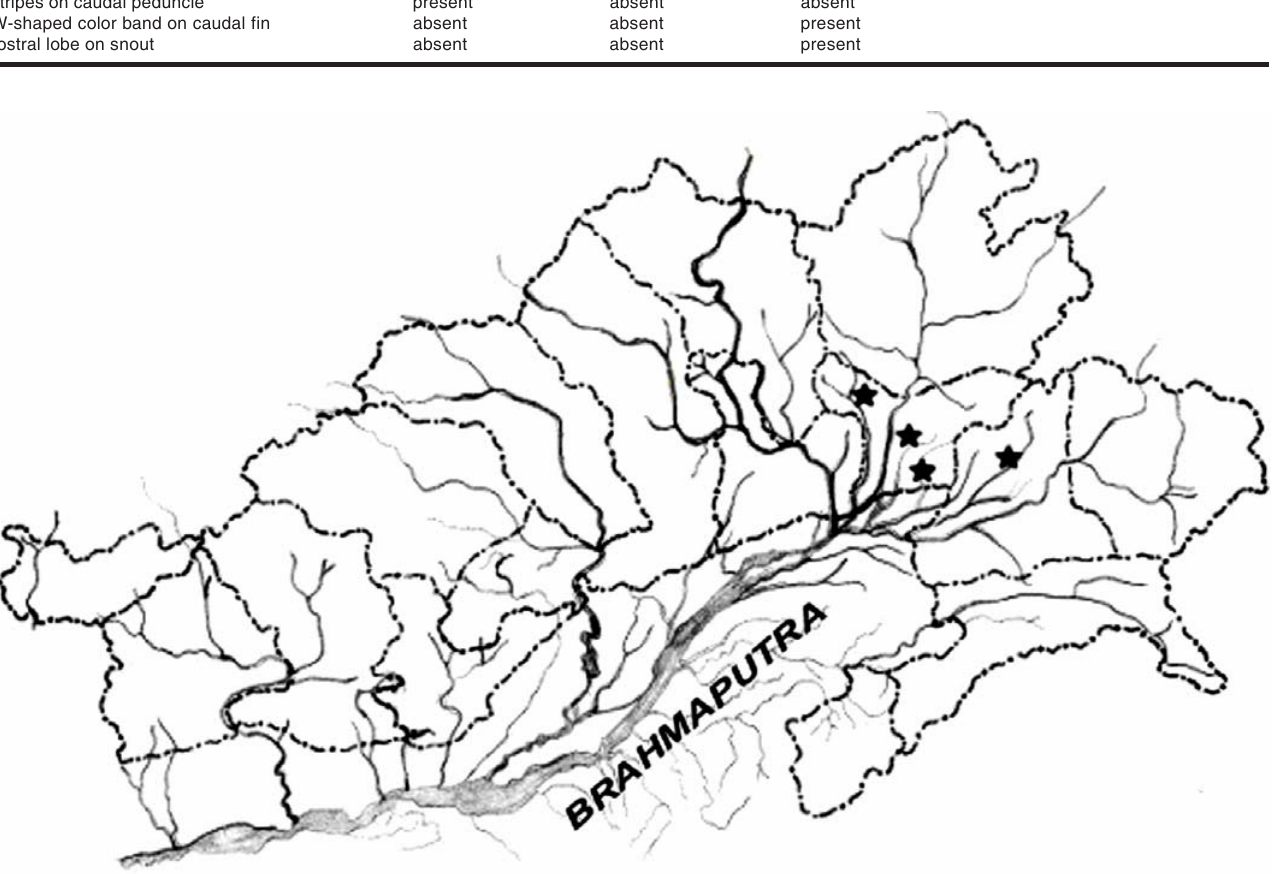
Figure 1. Map showing collection site of Garra arupi sp. nov.